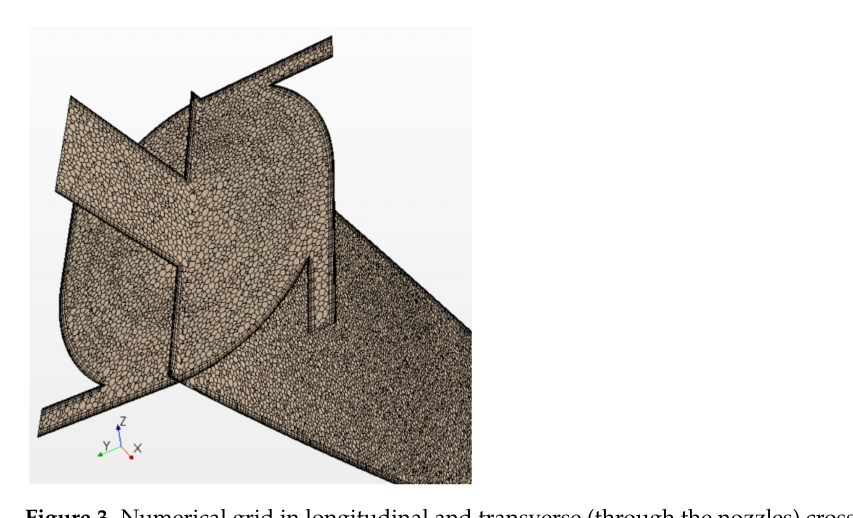
Figure 3. Numerical grid in longitudinal and transverse (through the nozzles) cross-sections of the vortex